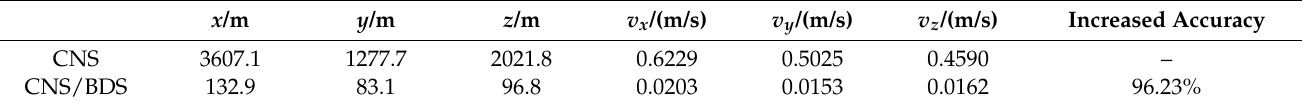
Table 4. RMSEs of the position and velocity of the CNS and CNS/BDS in three directions.